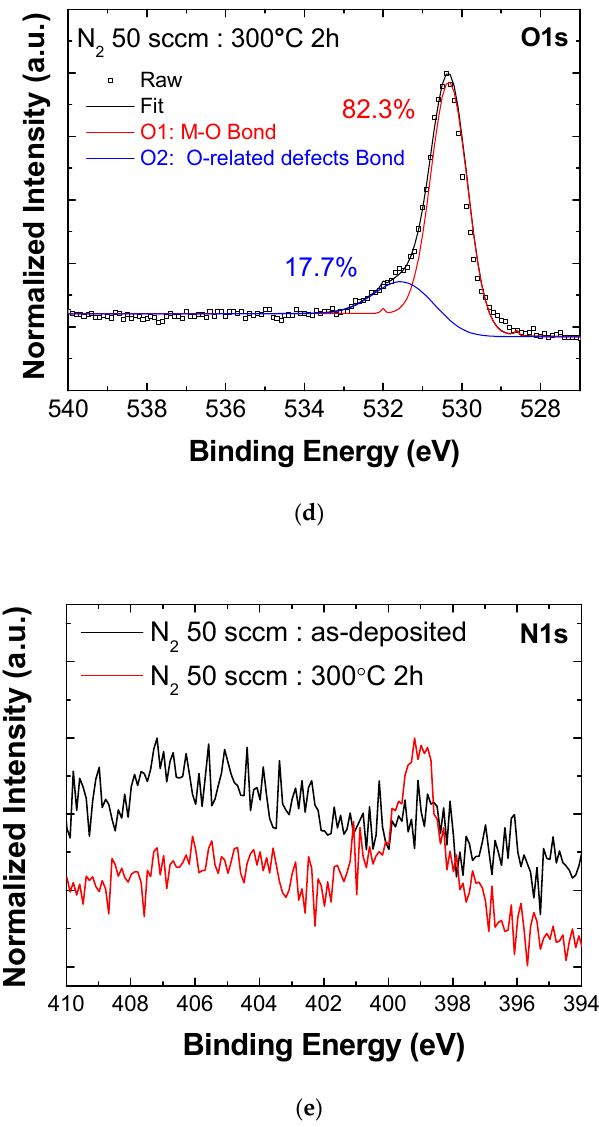
Figure 5. XPS O 1s peaks of ( a ) as-deposited Cu x O, ( b ) annealed Cu x O, ( c ) as-deposited CuON, and ( d ) annealed CuON. ( e ) XPS N 1s spectra of as-deposited CuON and annealed CuON.